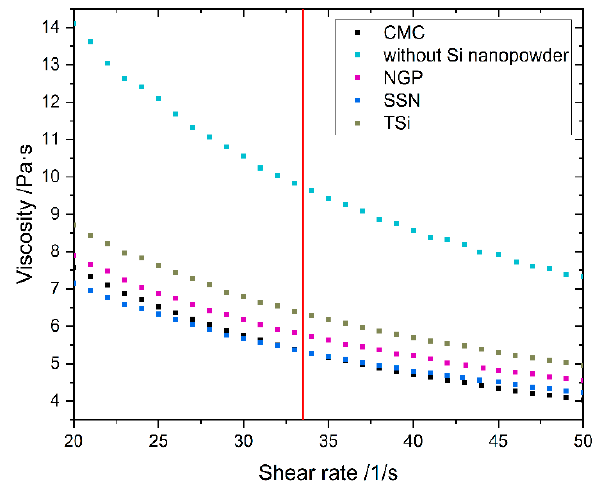
Figure A3. Viscosity of the slurries and the CMC solution for an application-oriented shear-rate range; the used shear-rate of 33.3 1/s is marked with a red line.